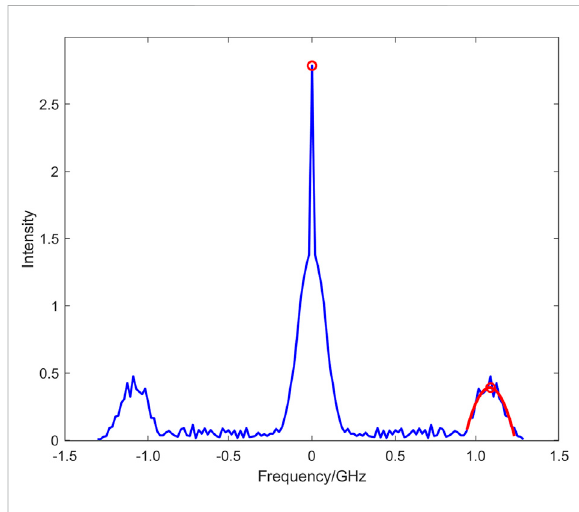
FIGURE 6 The height error of step 1 and step 2 under different rotation